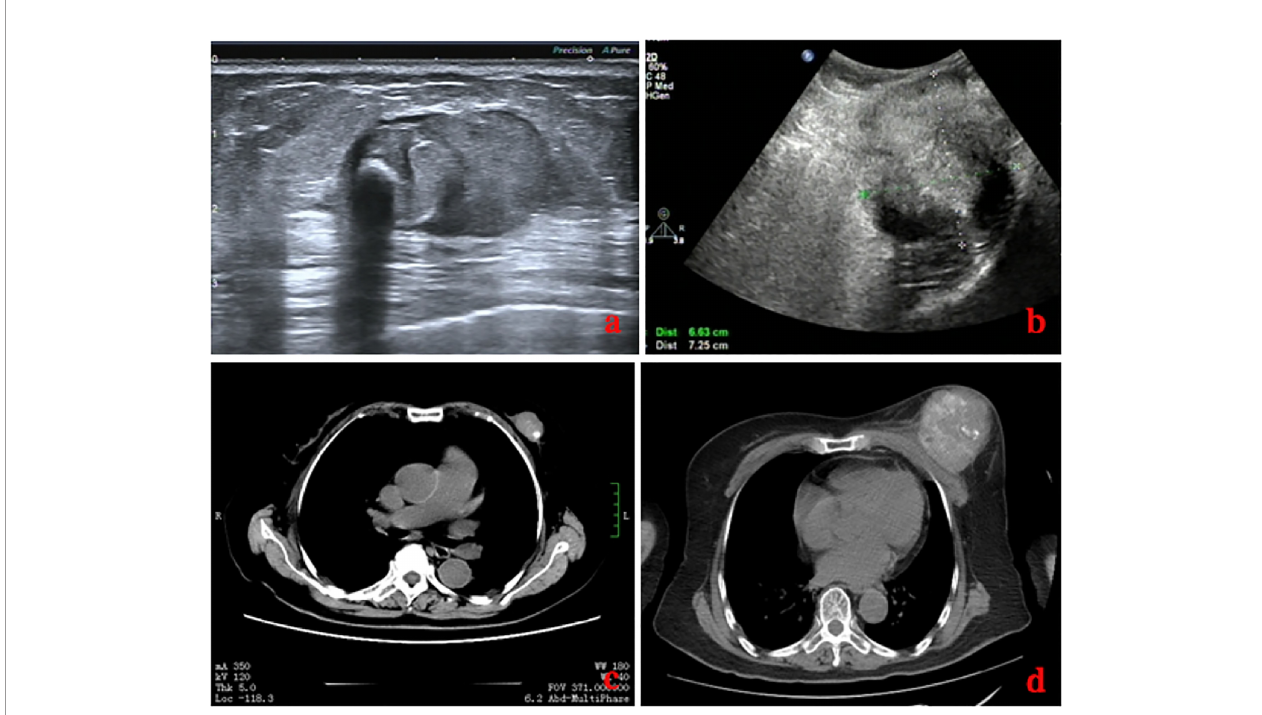
FIGURE 1 | Comparison of images on US (A, B) and CT (C, D) of the patient before and after 8 months. Eight months later, the lesion was much larger with unclear boundaries, and there were much more calci fi cations.